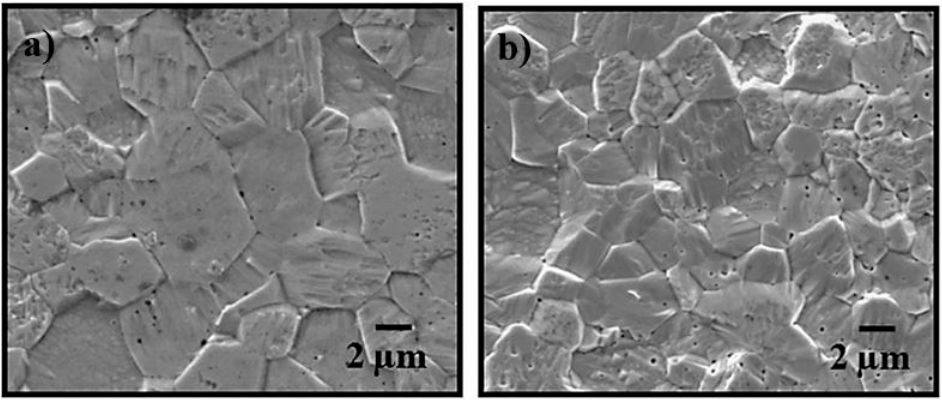
Figure 5. SEM micrographs: ( a ) conventional sintering and ( b ) microwave sintering [37]. The milling process of powders might enhance the sintering process. However,